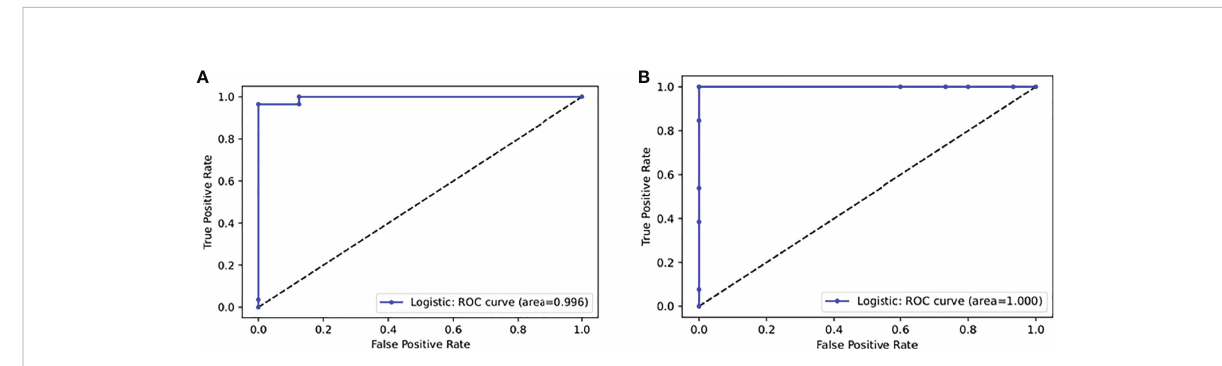
FIGURE 1 Receiver Operating Characteristic (ROC) curves produced by (A) linear SVM to predict CCC on 44 patients and (B) random forest to predict CCC stage on 28